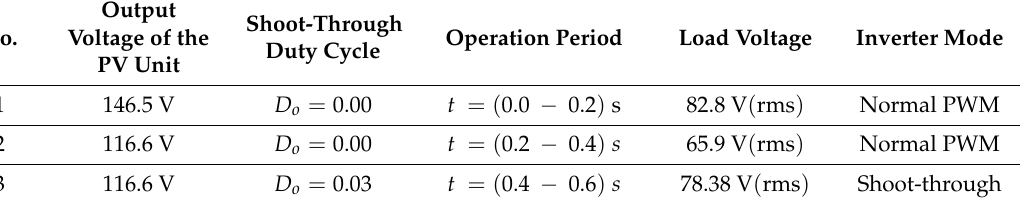
Table 3. Dynamic operation states.